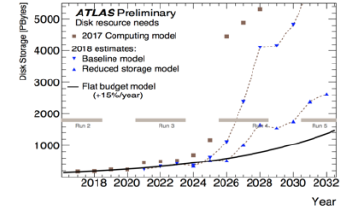
Fig. 3. CPU (left) and disk storage (right) requirements prediction for Run3 and High-Luminosity LHC periods [12]. Approaches to solve CPU and storage shortfall are